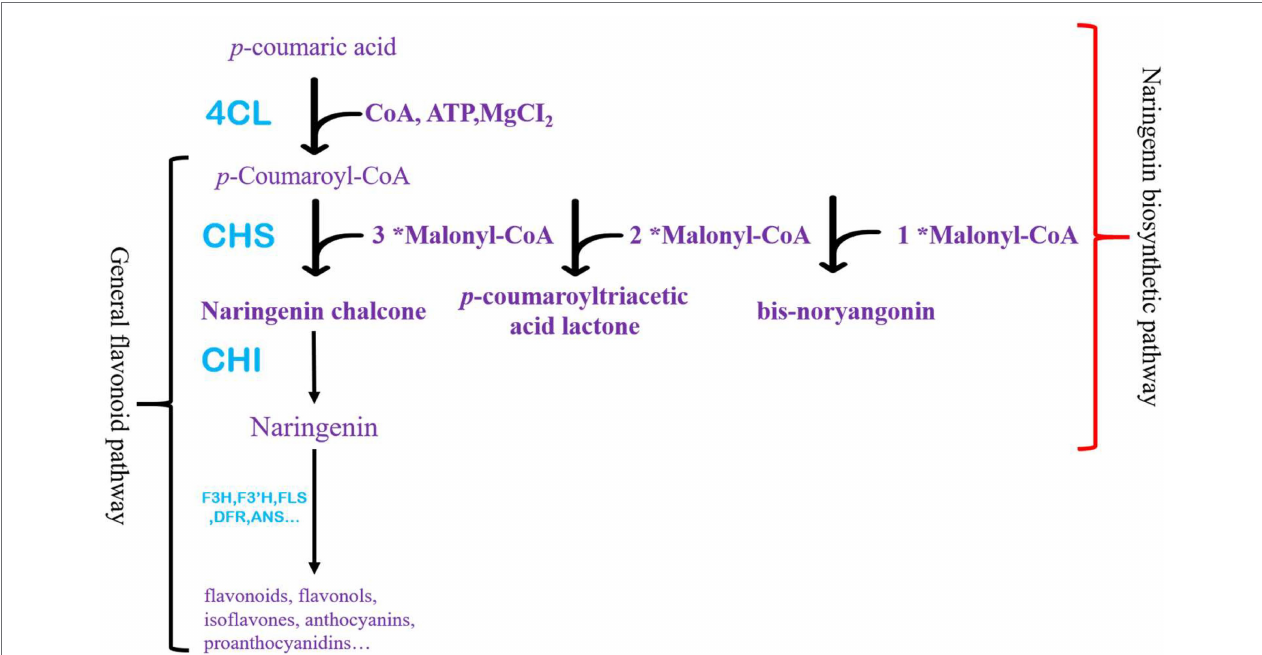
FIGURE 1 | Naringenin and flavonoids pathway in plants. Red brackets represent the naringenin synthesis pathway starting from p -coumaric acid, and black brackets generally represent flavonoid synthesis pathways in